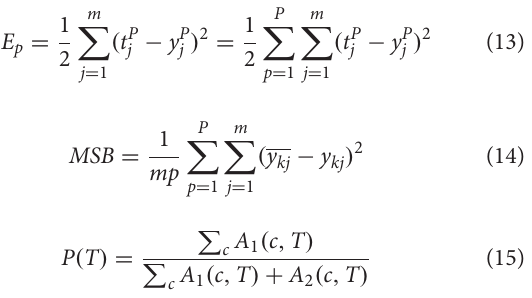
Eq. (13) ∼ Eq. (15) indicate the BPNN algorithm’s global error. The Mean Square Error in the training process is calculated by